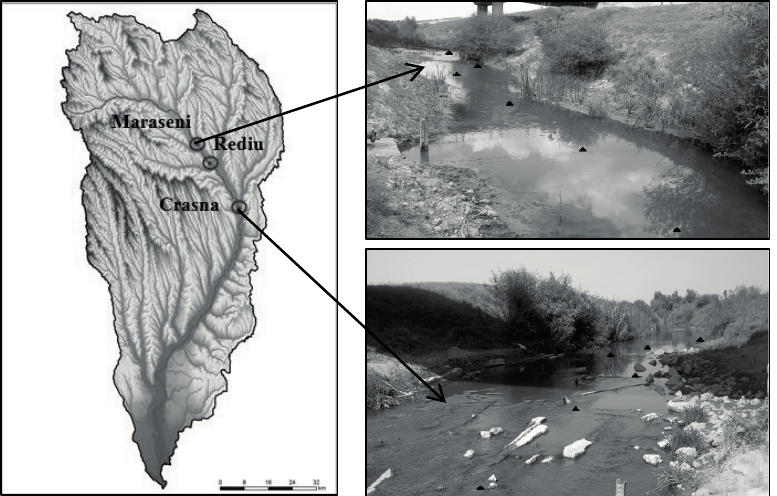
Fig. 3 Sampling sections for testing the portable sunder in different conditions, along the Barlad River ( ▲ , different sampling